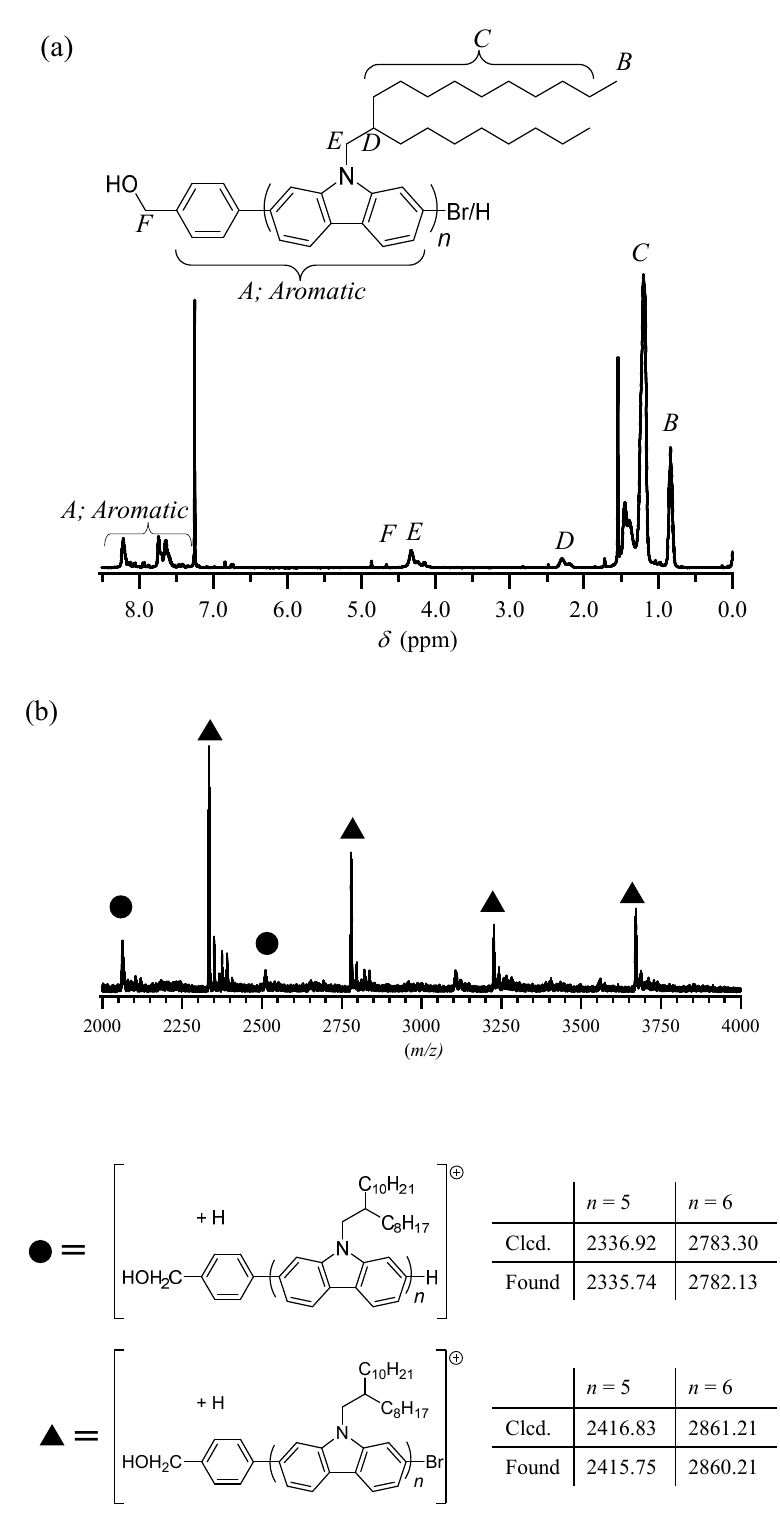
Figure 6. 1 H NMR and MALDI-TOF mass spectral analysis on HOCH 2 −2,7-PCz obtained from run 6 (Table 1) ( a ) 1 H NMR in CDCl 3 (400 MHz). ( b ) MALDI-TOF mass spectrum with peak assign- ments.